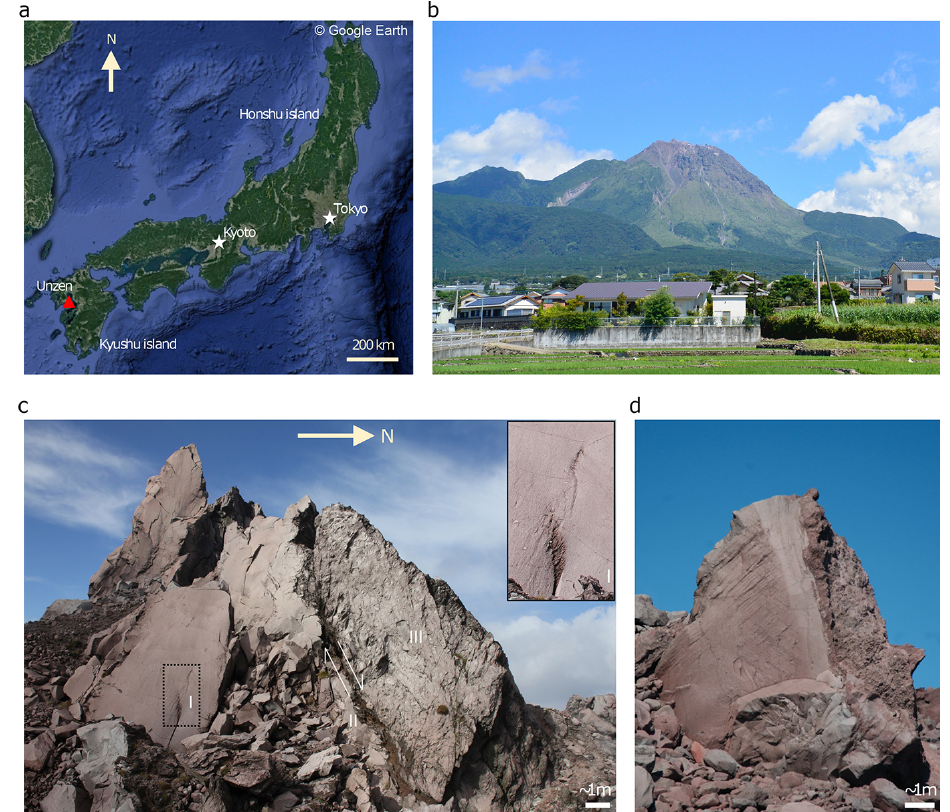
Figure 1. (a) © Google Earth image showing the location of Unzen volcano on the island of Kyushu, Japan. (b) Photograph of Unzen volcano, looking northwest, viewed from near Onokoba in the suburbs of Shimabara city. (c) Photo of the relict 1994–1995 spine at Unzen volcano (looking westward), showing (I) the central shear zone (i.e. the cavitation structures detailed in Smith et al., 2001, further expanded in the inset), (II) the marginal shear zone bordered by a fault (dark orange–brown colour), and (III) a large block of sintered breccia of earlier domes, which has become welded to the fault material and extruded with the spine. Adapted from Hornby et al. (2015). (d) Photograph of a fragment of the spine showing the primary internal structure of the shear zone, bordered by a set of closely spaced, inclined fractures to the left and indurated breccia to the